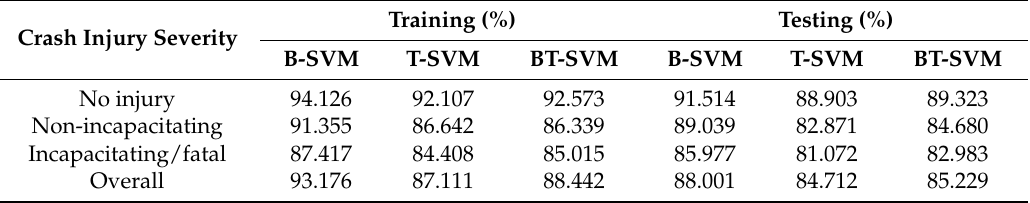
Table 8. Prediction accuracy of OL model in the training and